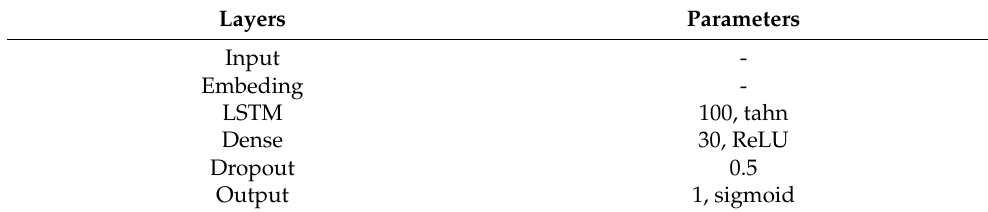
Table 3. Topology of the LSTM model.